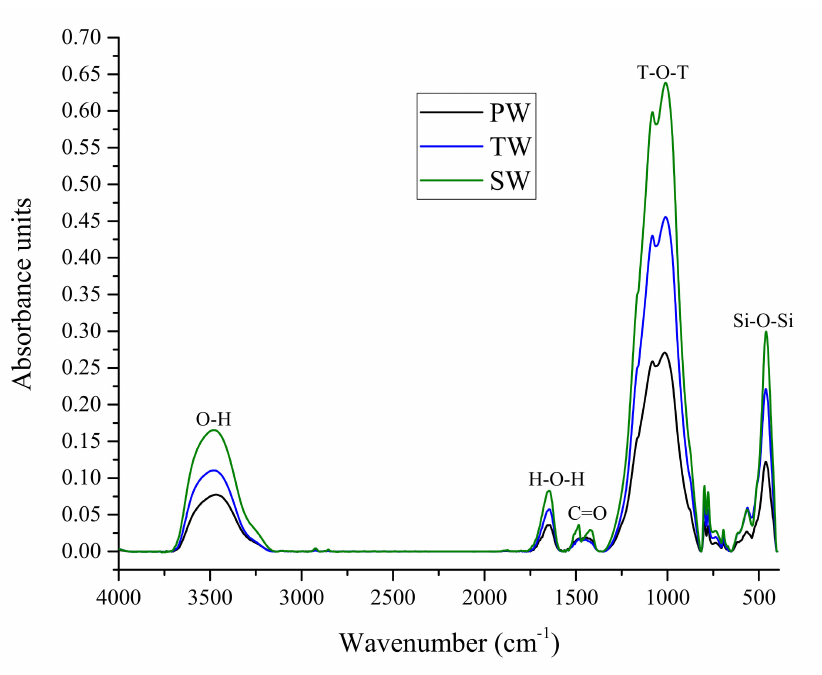
Figure 5. FT-IR spectra of AAM produced with di ff erent types of